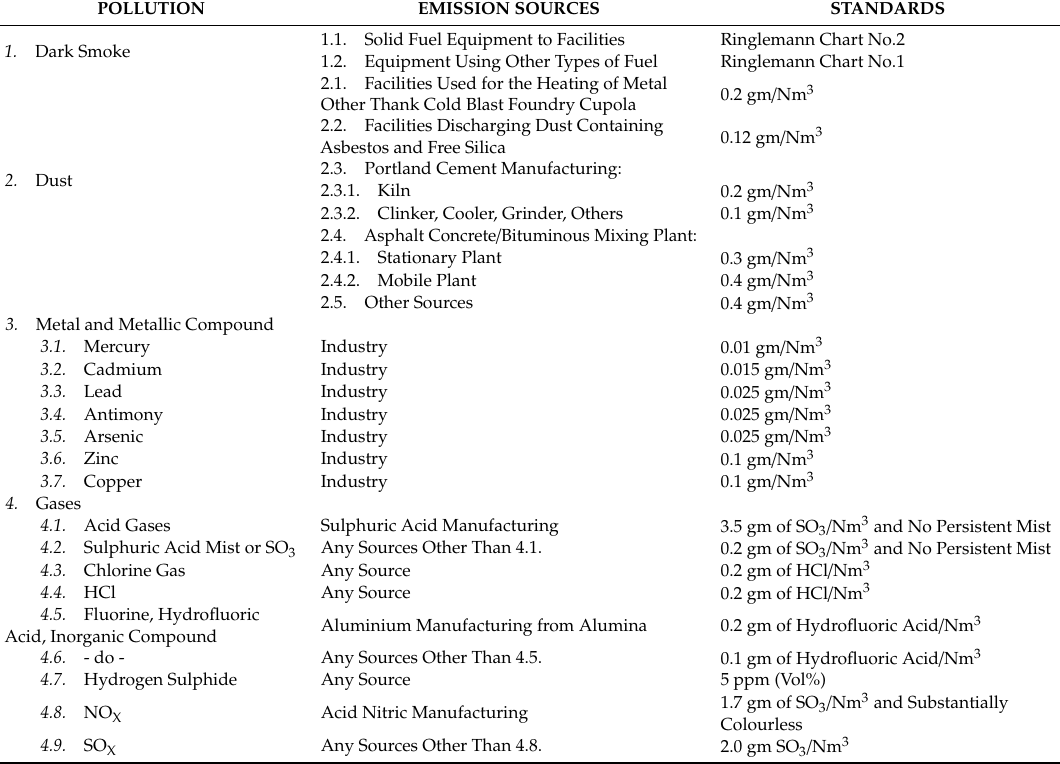
Table A2. Stack gas emission standards